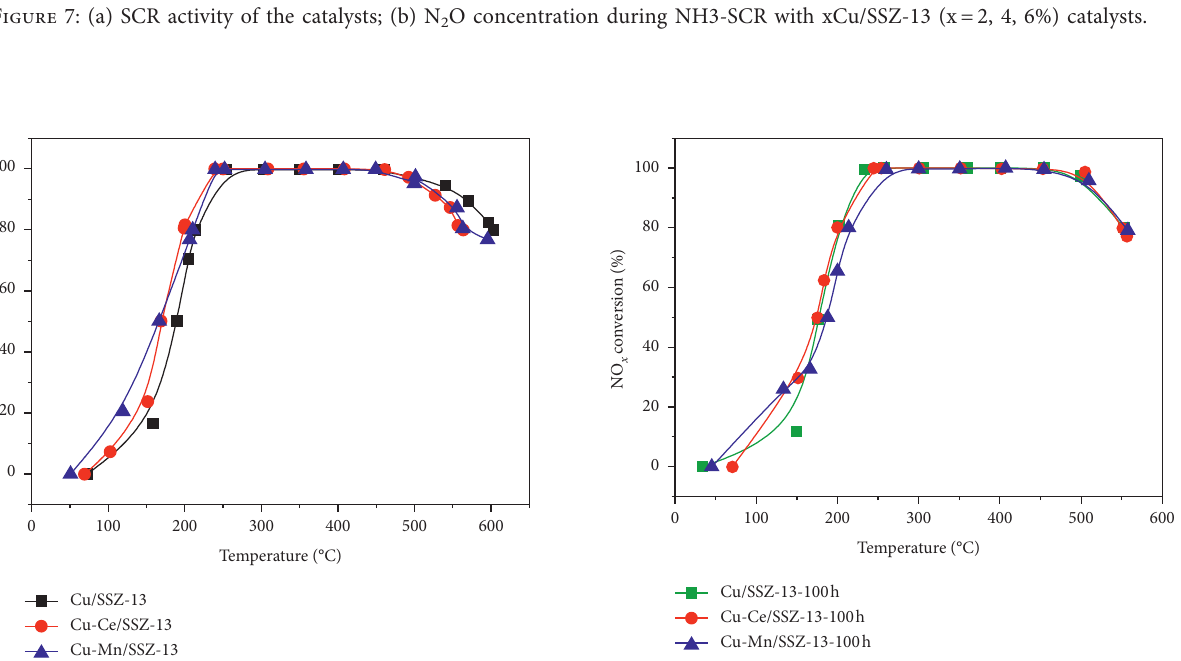
2 O concentration during NH3-SCR with xCu/SSZ-13 (x